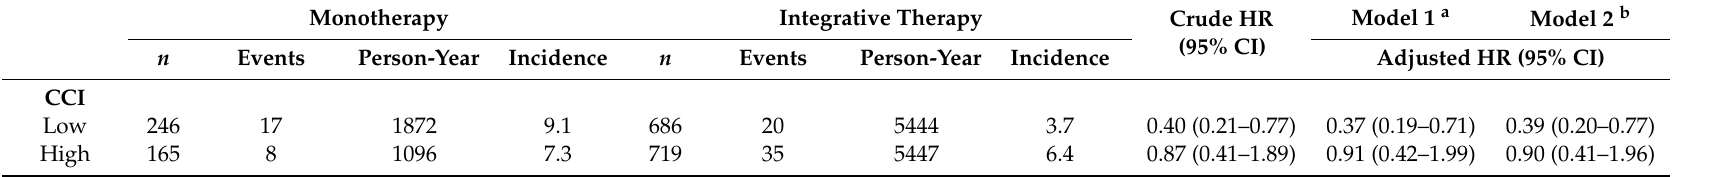
Table 4. Risk of PD in patients with IBD according to KM treatment in the CCI